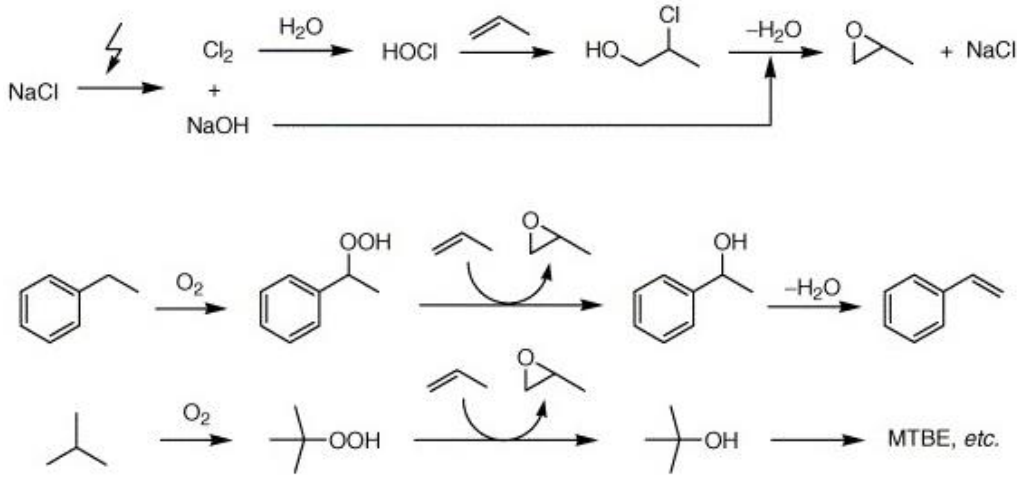
Figure 1. Mechanisms of traditional epoxidation process of olefins [3]. MTBE: Methyl tert-butyl ether.